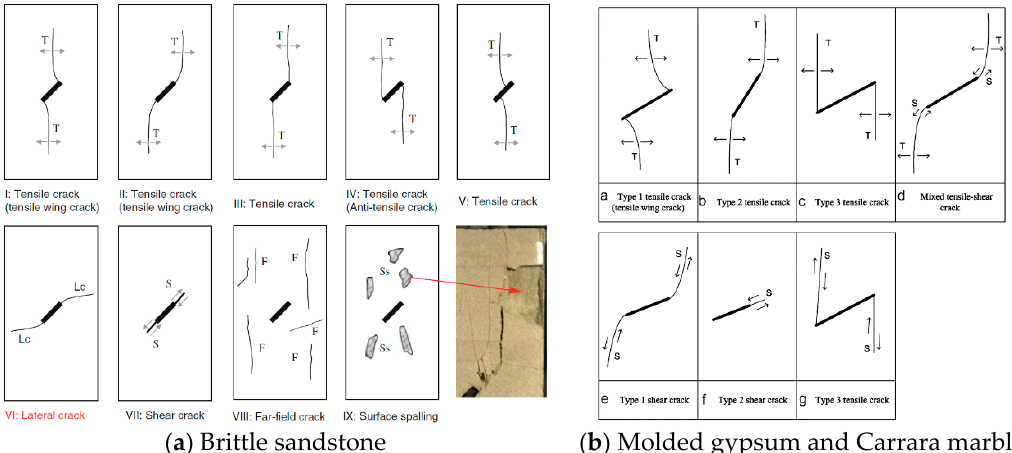
Figure 16. Various crack types obtained by scholars. ( a ) Brittle sandstone specimens by Yang and Jing [10]; ( b ) molded gypsum and Carrara marble specimens by Wong and Einstein [8,9].